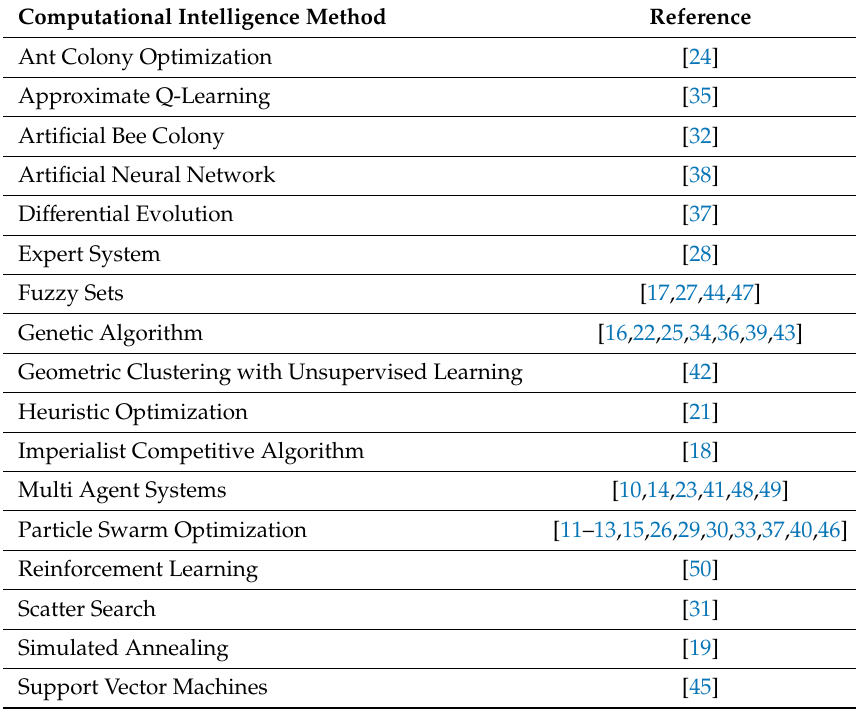
Table 3. Taxonomy of the computational intelligence methods of the reviewed